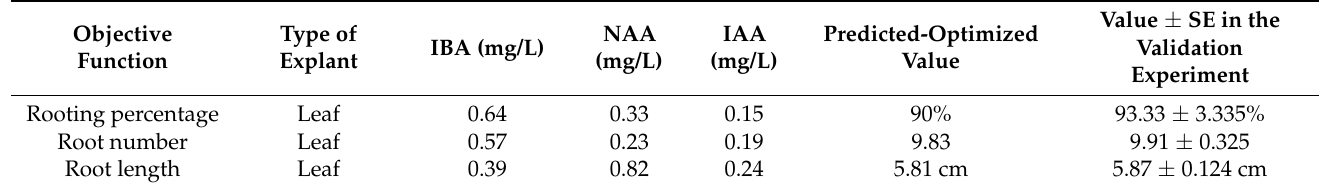
Table 4. The results of optimization process via GA as well as the validation experiment for in vitro rooting of P. caerulea